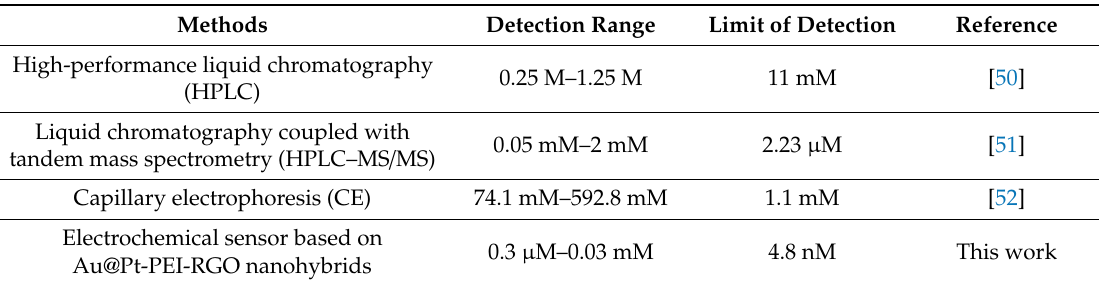
Table 1. Comparison of the reported methods for chicoric acid determination. PEI, polyetherimide; RGO, reduced graphene oxide.